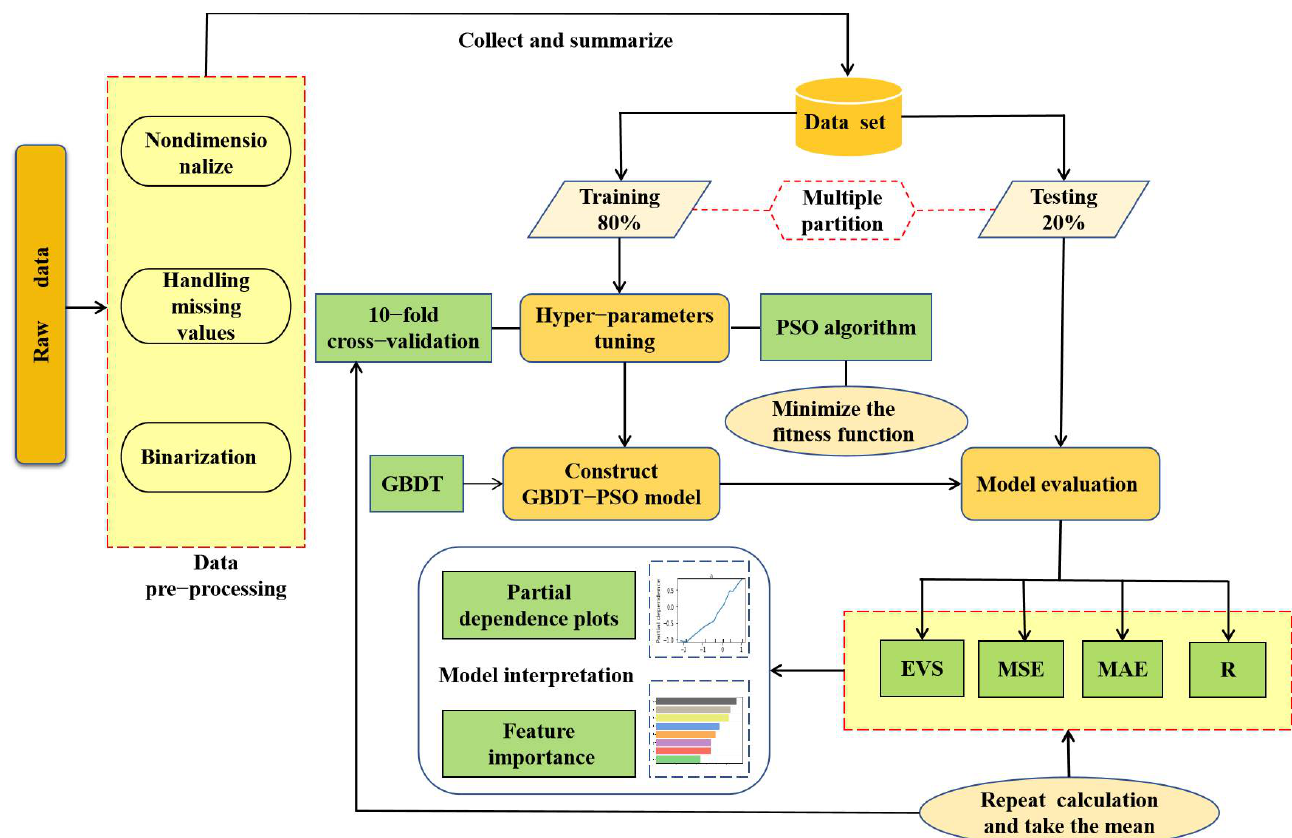
Figure 4. General process of GBDT–PSO model construction and evaluation.